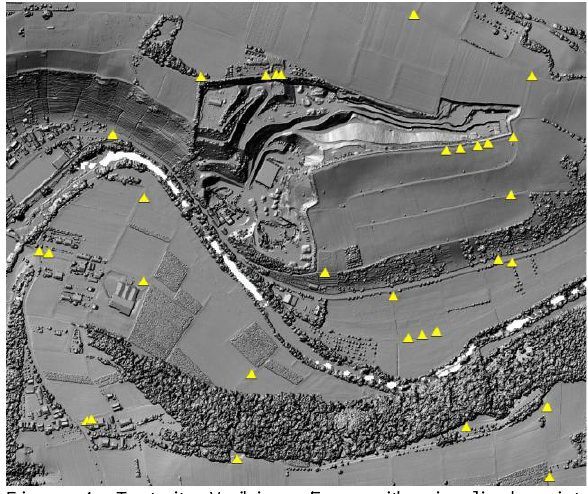
Figure 5: Test-site Vaihingen/Enz, with planned flight lines and camera stations from GPS